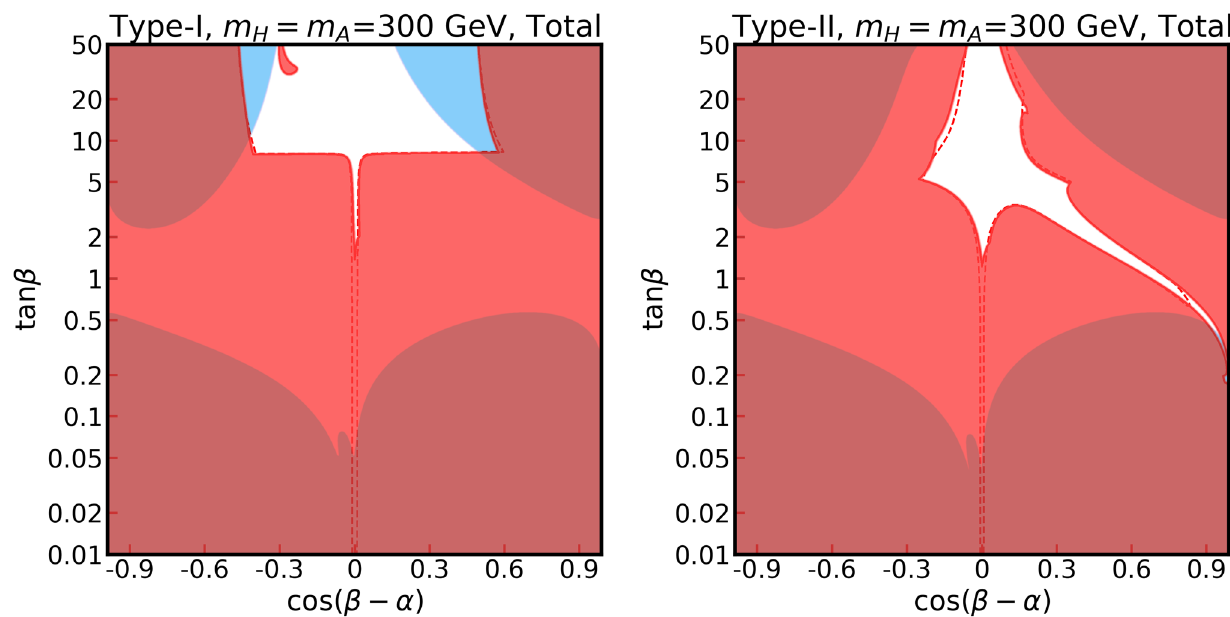
Fig. 6 Combined study in the cos (β − α) -tan β plane, with assumed degenerate heavy Higgs masses of 300 GeV. The dashed lines represent tree-level results and the red represent loop-level constrained regions.